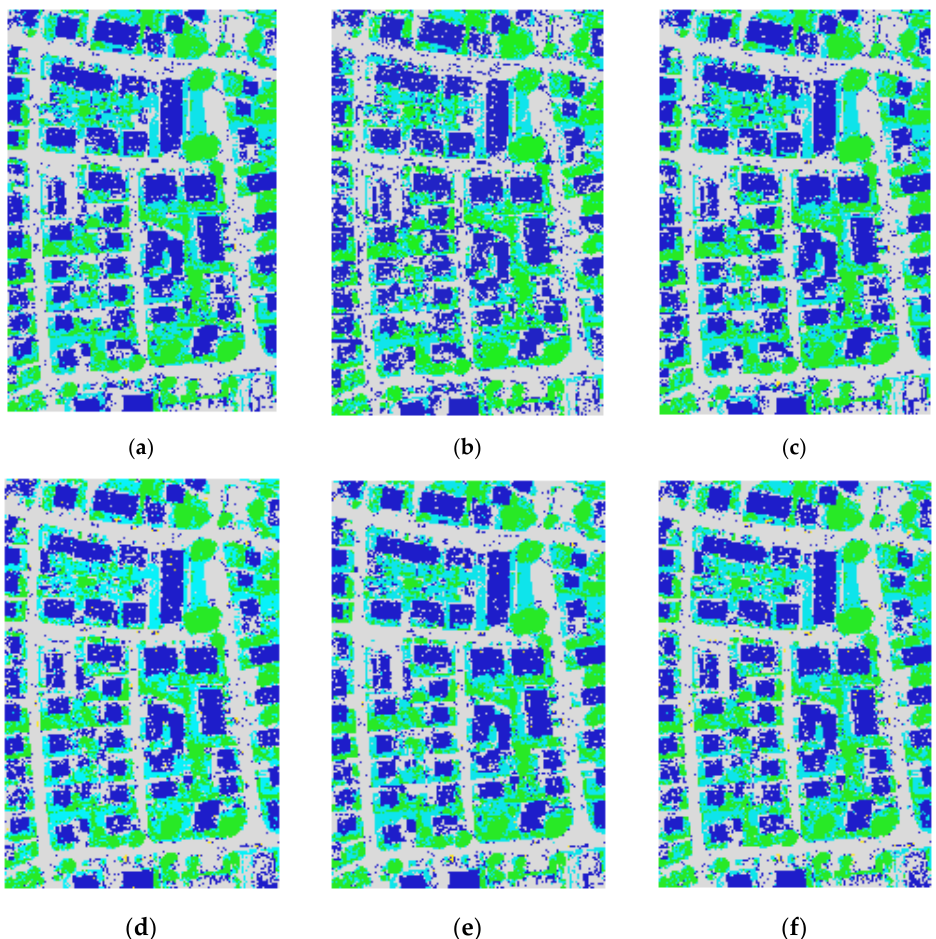
Figure 14. Classification results for ISPRS Vaihingen dataset. ( a ) DT, ( b ) AdaBoost, ( c ) GBM, ( d ) XGBoost, ( e ) Light GBM, and ( f ) RF.